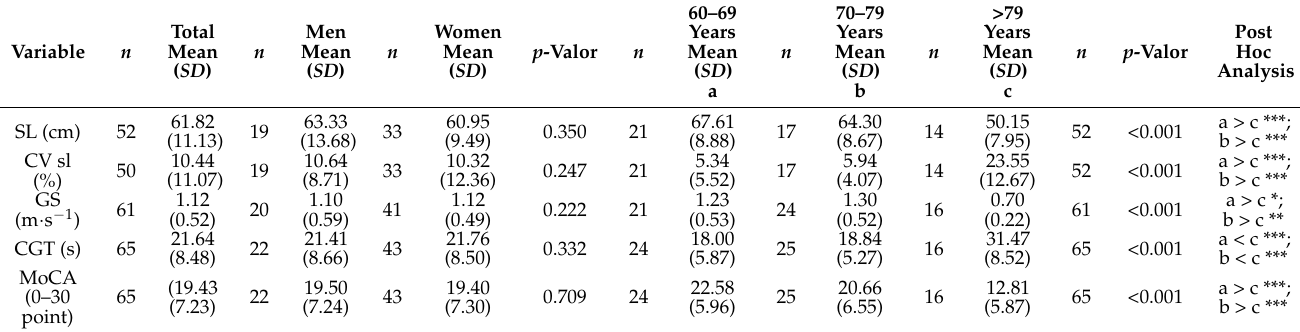
Table 2. Results of gait variables and the Montreal Cognitive Assessment (MoCA) test according to sex and age groups.